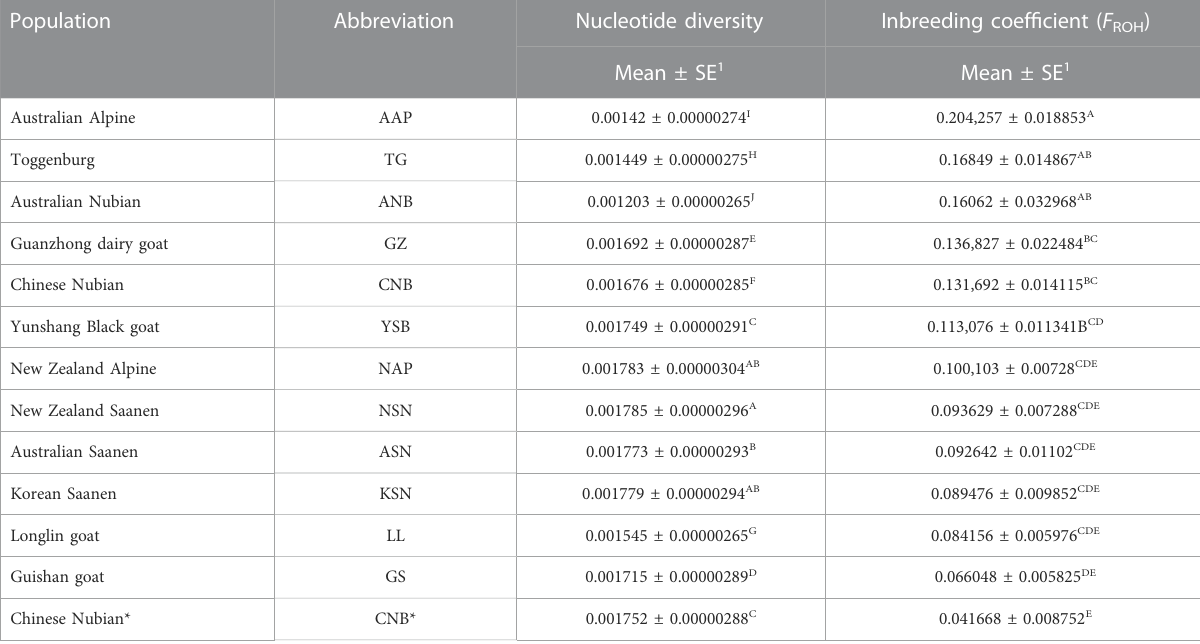
TABLE 2 The summary of nucleotide diversity and inbreeding coef fi cient for 13 goat